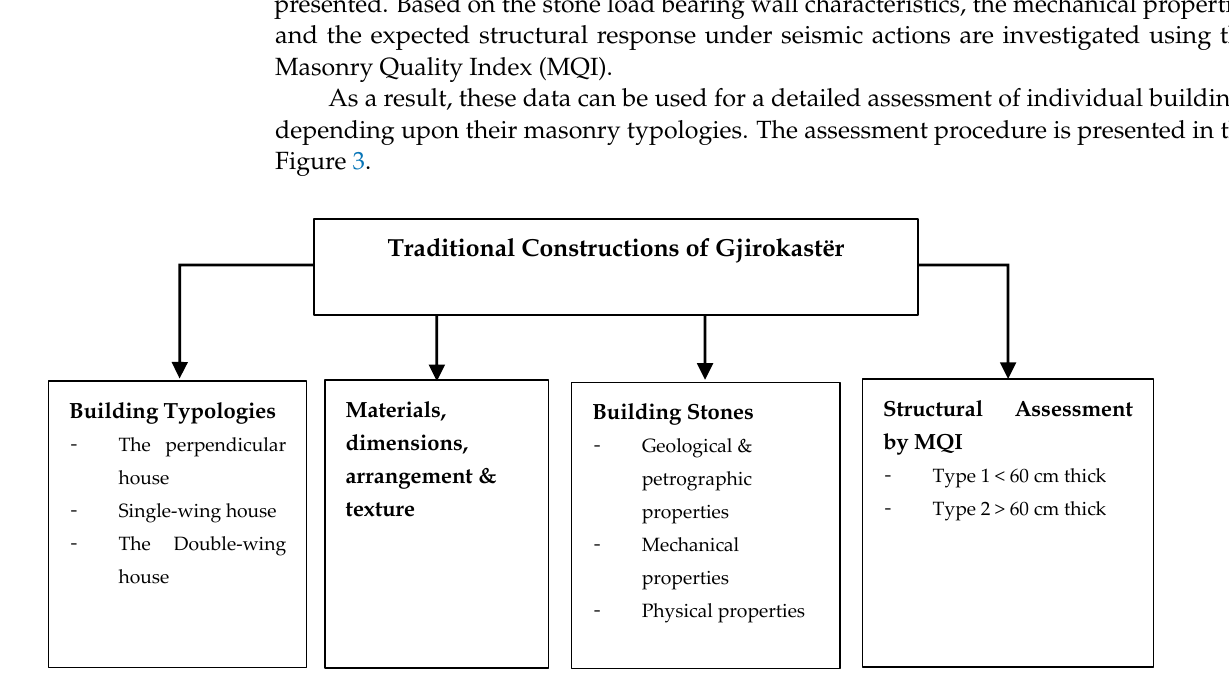
Figure 3. Experimental campaign flowchart.